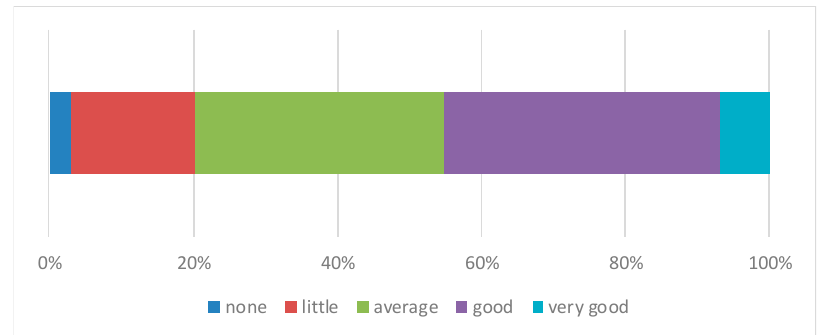
Figure 6. Perception of the prior mathematical basis for approaching university mathematics.